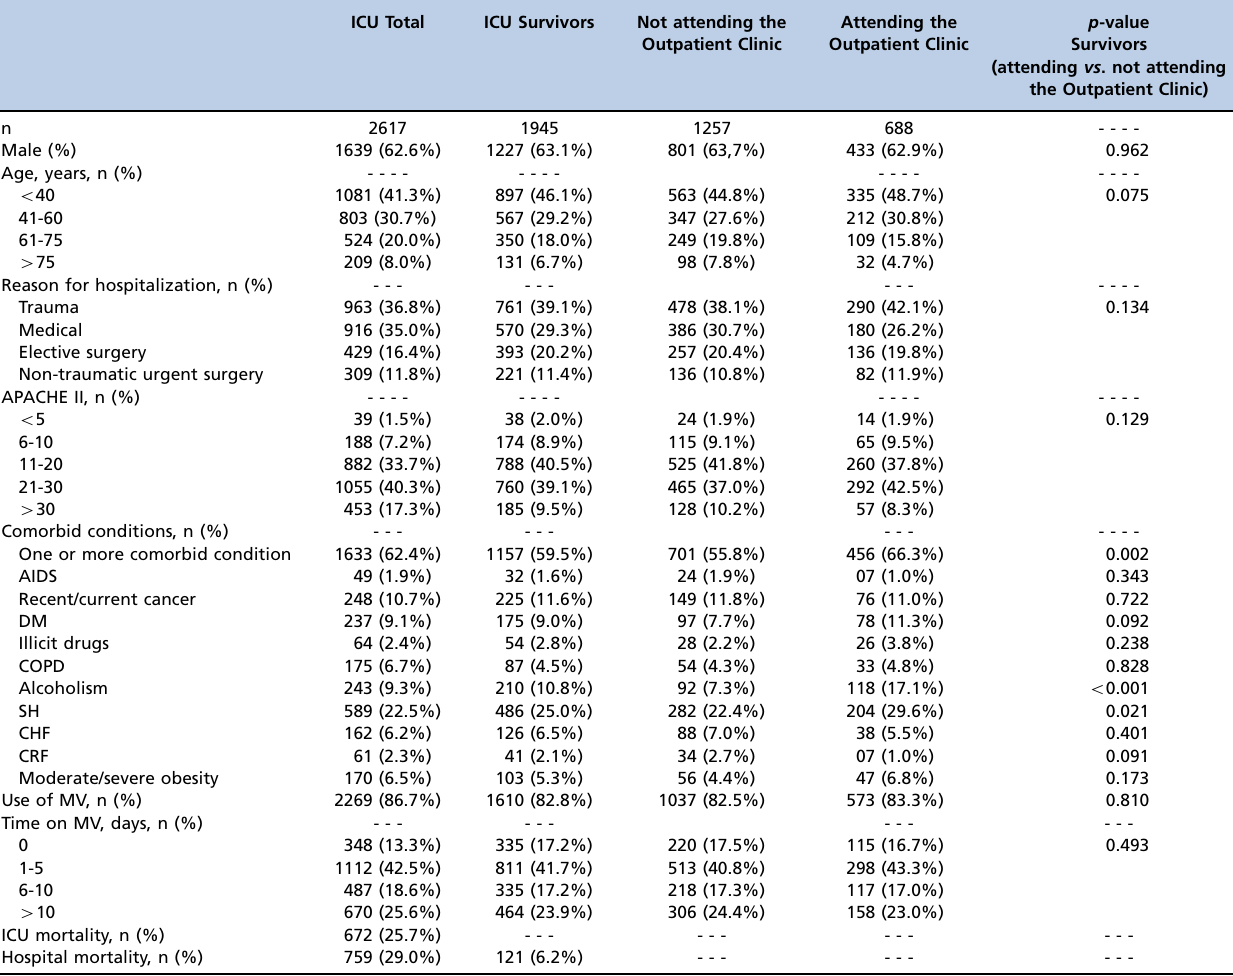
Table 1 - Patient demographic and clinical